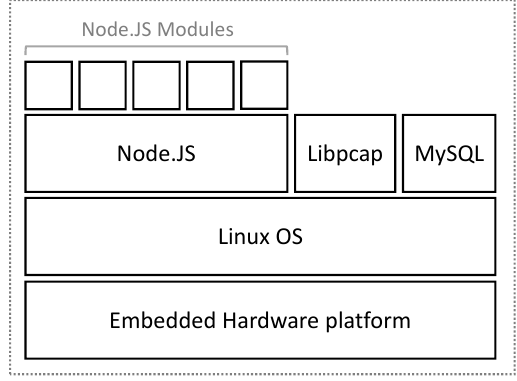
Figure 6. Software architecture of the prototype.